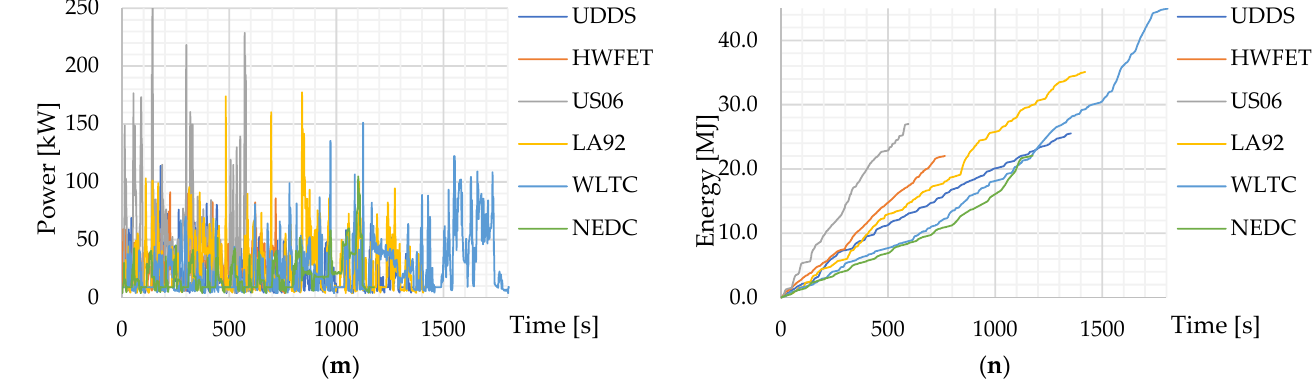
Figure 10. 2018 Toyota Camry LE—waveforms of instantaneous values: ( a ) vehicle speed obtained from the simulation of selected road tests; ( b ) distance travelled by the vehicle obtained from simulation of selected road tests; ( c ) angular velocity of the crankshaft of the vehicle engine obtained from simulation of selected road tests; ( d ) torque produced at the crankshaft by the vehicle engine obtained from simulation of selected road tests; ( e ) power generated by the engine obtained from simulation of selected road tests; ( f ) mechanical energy generated by the vehicle engine obtained from simulation of selected road tests; ( g ) power lost in the vehicle drivetrain obtained from simulation of selected road tests; ( h ) energy lost in the vehicle transmission obtained from simulation of selected road tests; ( i ) power lost in the braking system of the 2018 Toyota Camry LE vehicle obtained from simulation of selected road tests; ( j ) energy lost in the vehicle braking system obtained from simulation of selected road tests; ( k ) power lost by vehicle rolling resistance forces obtained from simulation of selected road tests; ( l ) energy lost by vehicle rolling resistance forces obtained from simulation of selected road tests; ( m ) power delivered in the vehicle fuel stream obtained from simulation of selected road tests; ( n ) energy delivered in the fuel stream of the 2018 Toyota Camry LE vehicle obtained from simulation of selected road tests. Table 5. Summary of the energy parameters obtained from the simulations of the 2018 Toyota Camry LE vehicle for selected road tests.